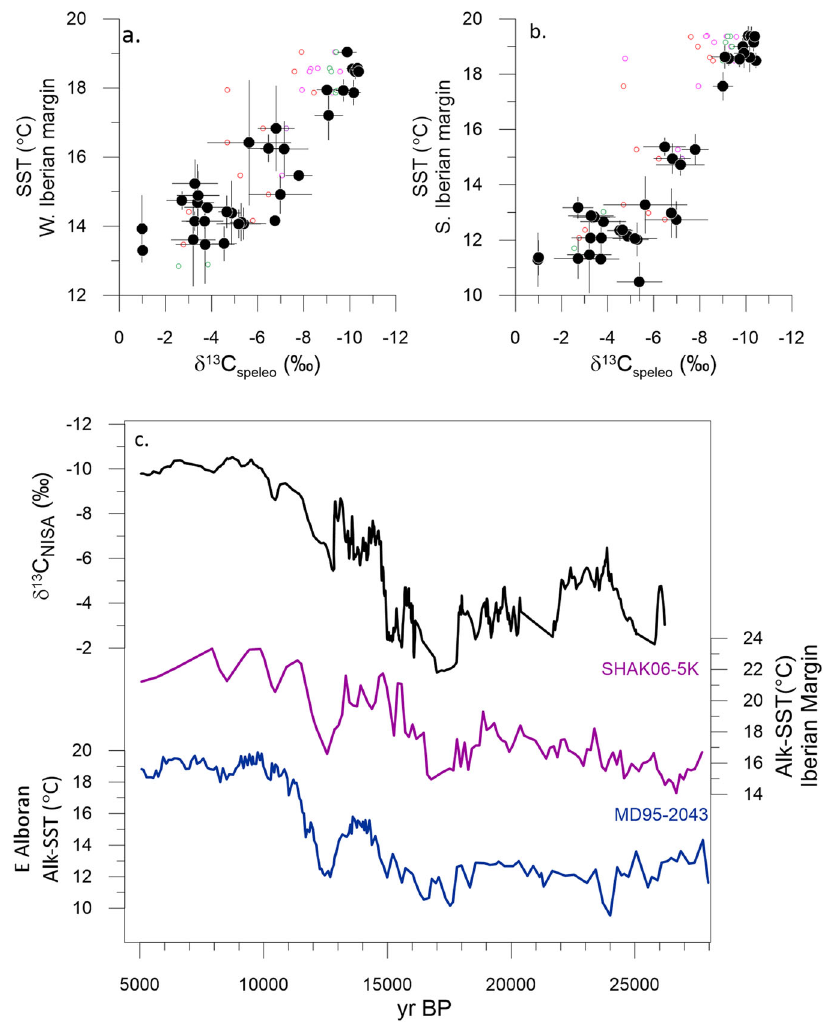
Fig. 3 Relationship between regional temperature and NW Iberian speleothem δ 13 C NISA over TI. a , b The scatterplots show δ 13 C NISA for fi xed time bins (500 years) from stalagmites Candela, Galia, Laura, and Alicia, vs alkenone SST from the S Iberian margin 95 and W Iberian Margin 29 respectively. Black symbols denote the average for the splice, and small colored symbols denote stalagmite increments where they do not comprise the splice, from Candela (red), Laura (brown, Galia (green) and Alicia (fuchsia). For the S. Iberian margin, r 2 = 0.87 and p « 0.01. For the W. Iberian margin, r 2 = 0.82 and p << 0.01. c Time series of the NISA δ 13 C NISA splice, and the alkenone SST from the MD95-2043 on S Iberian margin 95 and SHAK06-5K on W Iberian Margin 29